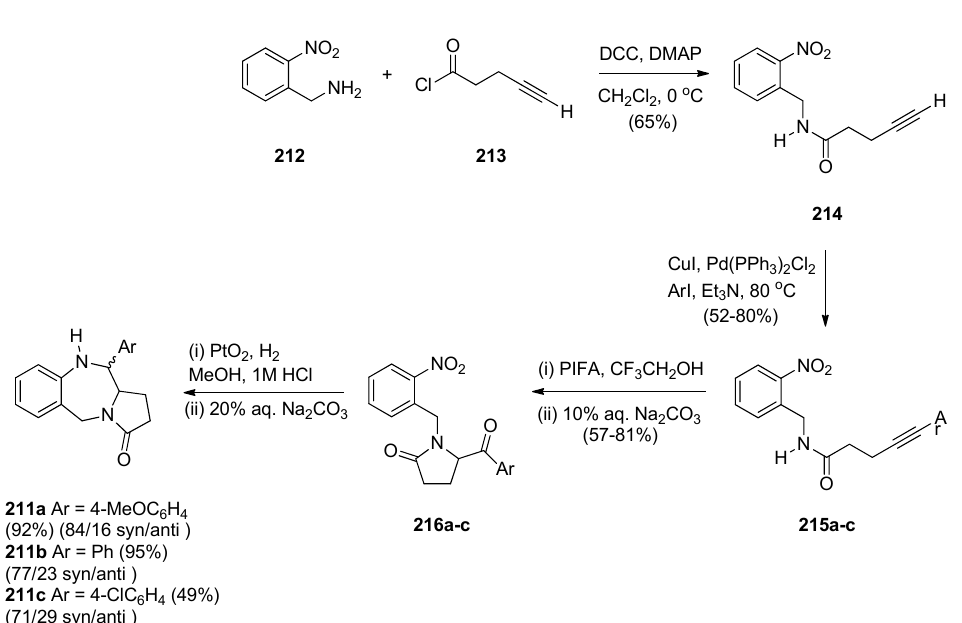
Scheme 35. Synthesis of PBD derivative 211a .